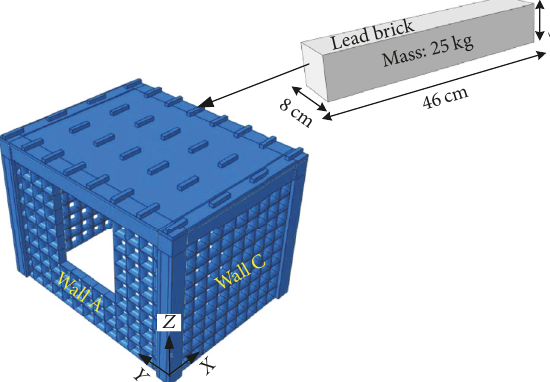
Figure 6: Distribution of additional weight on the model